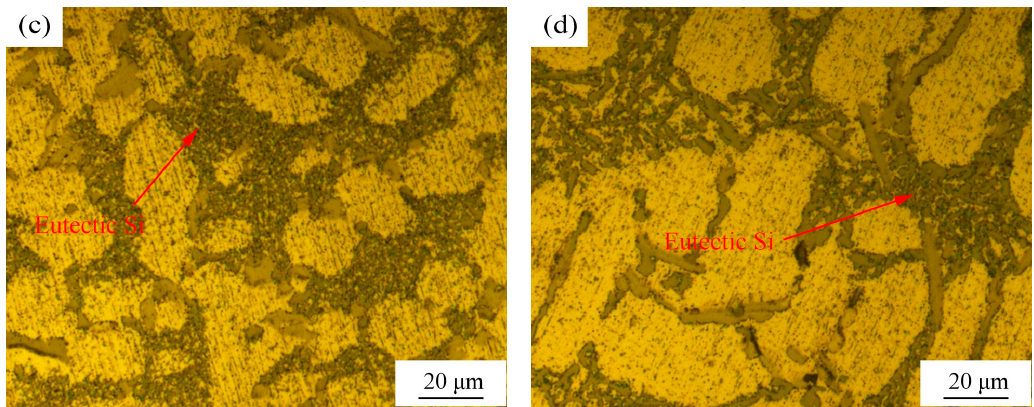
Figure 3. Effects of rare earth Yb addition on the eutectic Si phases in as-cast ADC12 alloys: ( a ) unmodified; ( b ) 0.4 wt % Yb; ( c ) 0.8 wt % Yb; ( d ) 1.2 wt % Yb.